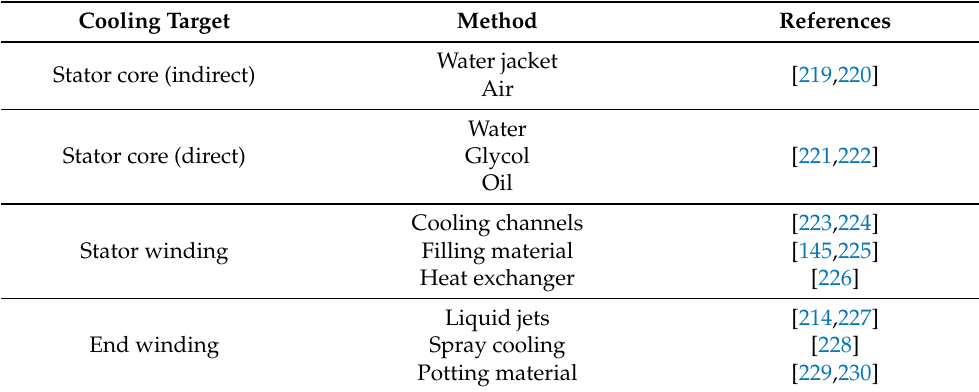
Table 2. Cooling technologies for electric motors (adapted [212] and references